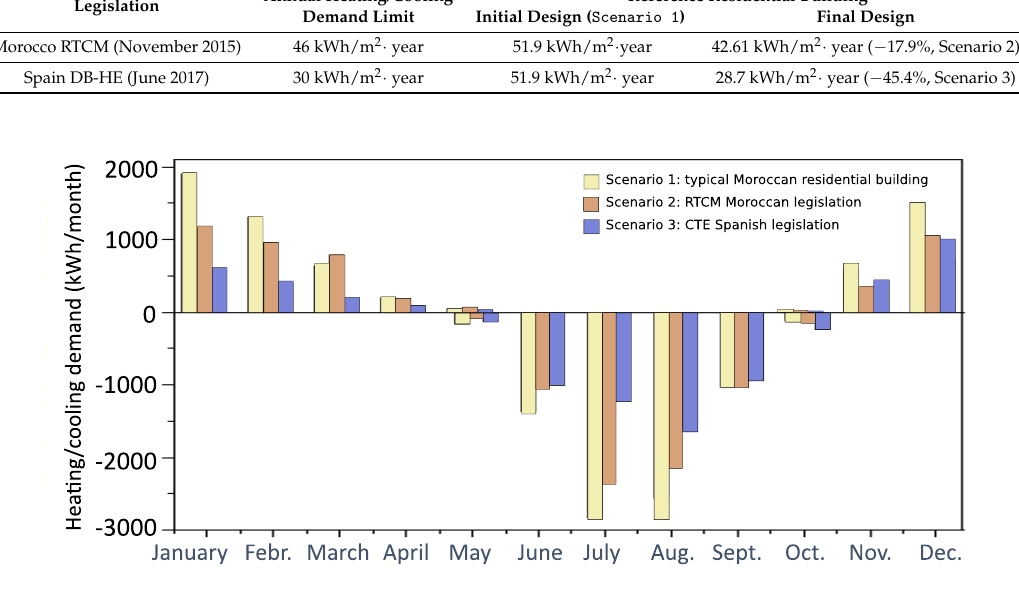
Figure 12. Monthly heating and cooling energy demands: comparison of